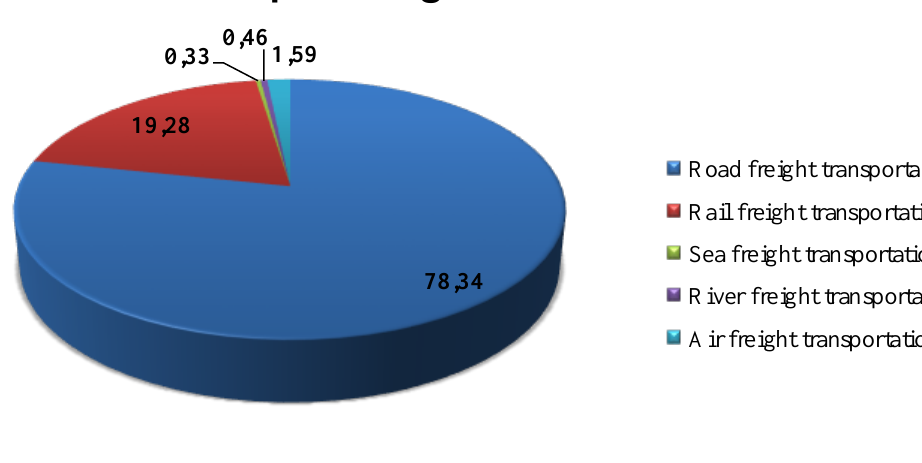
Fig. 1. Structure of the market of transport and logistics services in 2016